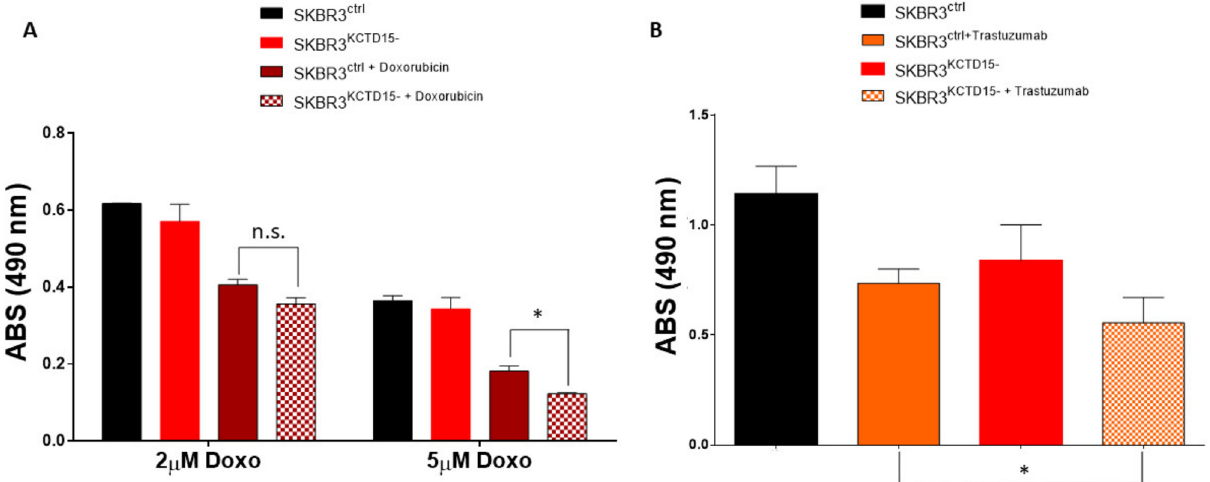
Figure 7. KCTD15 silencing increase the Doxorubicin and Trastuzumab sensitivity of SKBR3 cells. ( A ) MTT assay of untreated SKBR3ctrl and SKBR3 KCTD15 − (filled bars) and doxorubicin treated SKBR3 ctrl and SKBR3 KCTD15 − (squared bars) at 2 and 5 µ M for 16h. * = p -value < 0.05. ( B ) MTT assay of Trastuzumab treated SKBR3 ctrl (orange bar) and SKBR3 KCTD15 − (orange square bar) in comparison with the untreated control cells (SKBR3 ctrl , Black bar and SKBR3 KCTD15 − , Red bar). * = p -value < 0.05, Mann–Whitney t -test. n.s. = not significative. Error bars represent SD of three independent experiments.